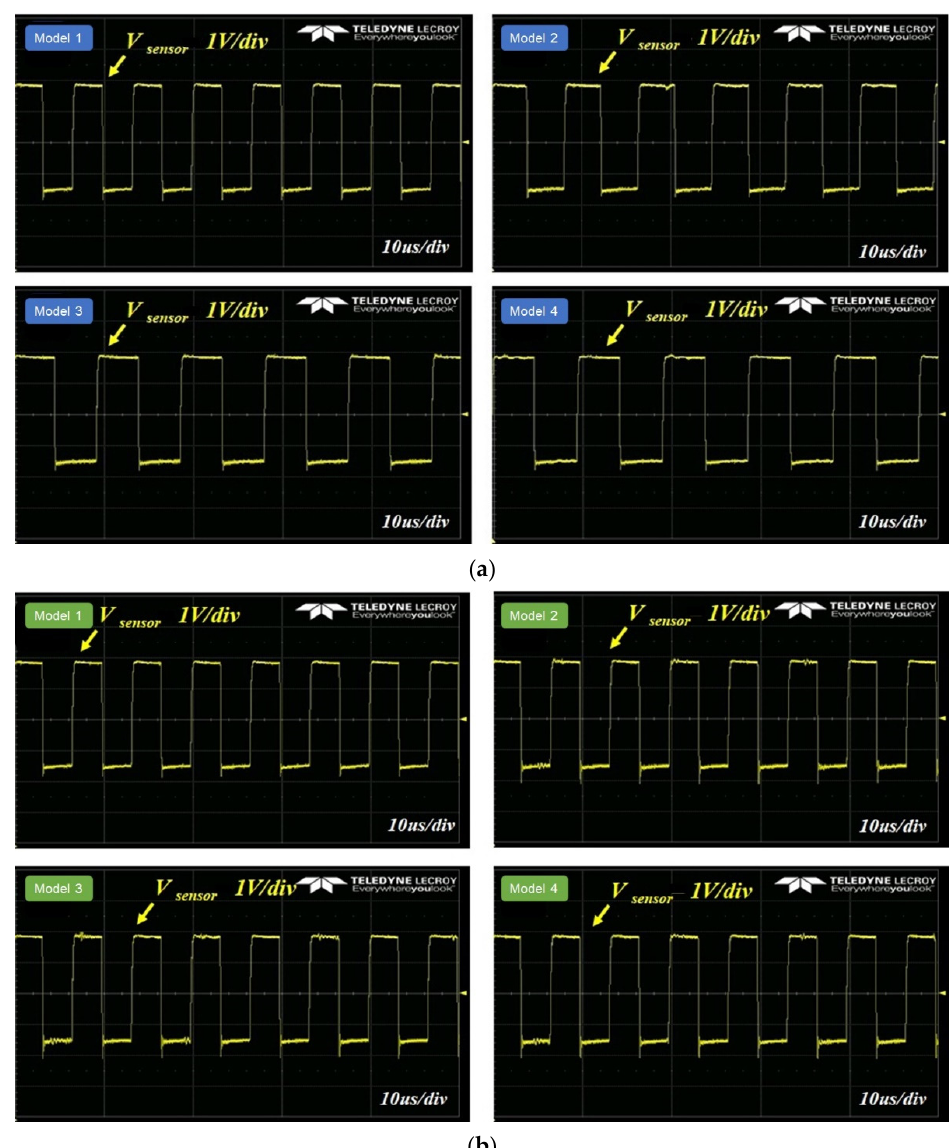
Figure 12. Experimental waveform of green frequency from the RGB sensor: ( a ) LED modules before calibration; ( b ) LED modules after calibration.